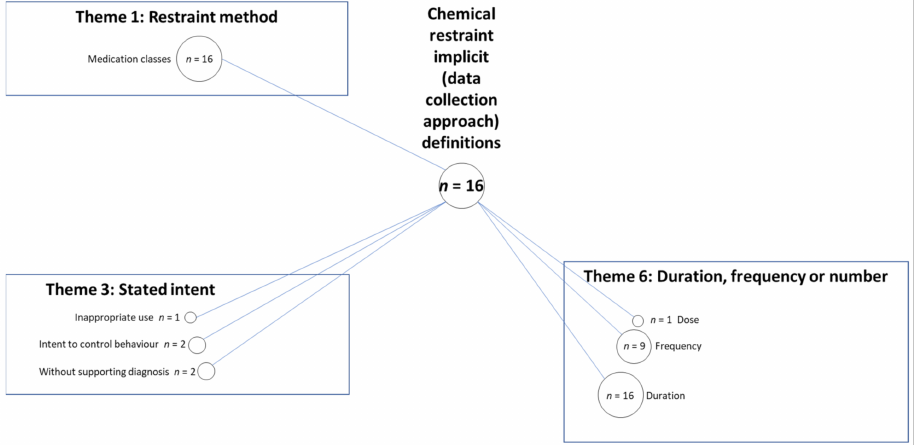
Figure 5. Codes and themes present within implicit definitions, based on data collection approach for chemical